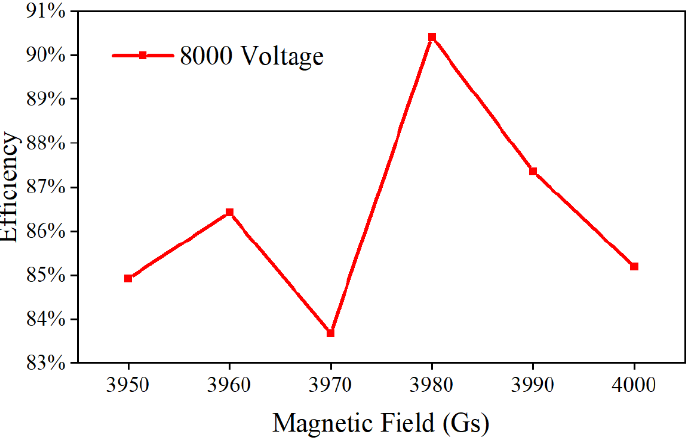
Figure 8. Calculated electronic efficiency of microwave operation in the π -mode at different magnetic field and 8000 voltages.